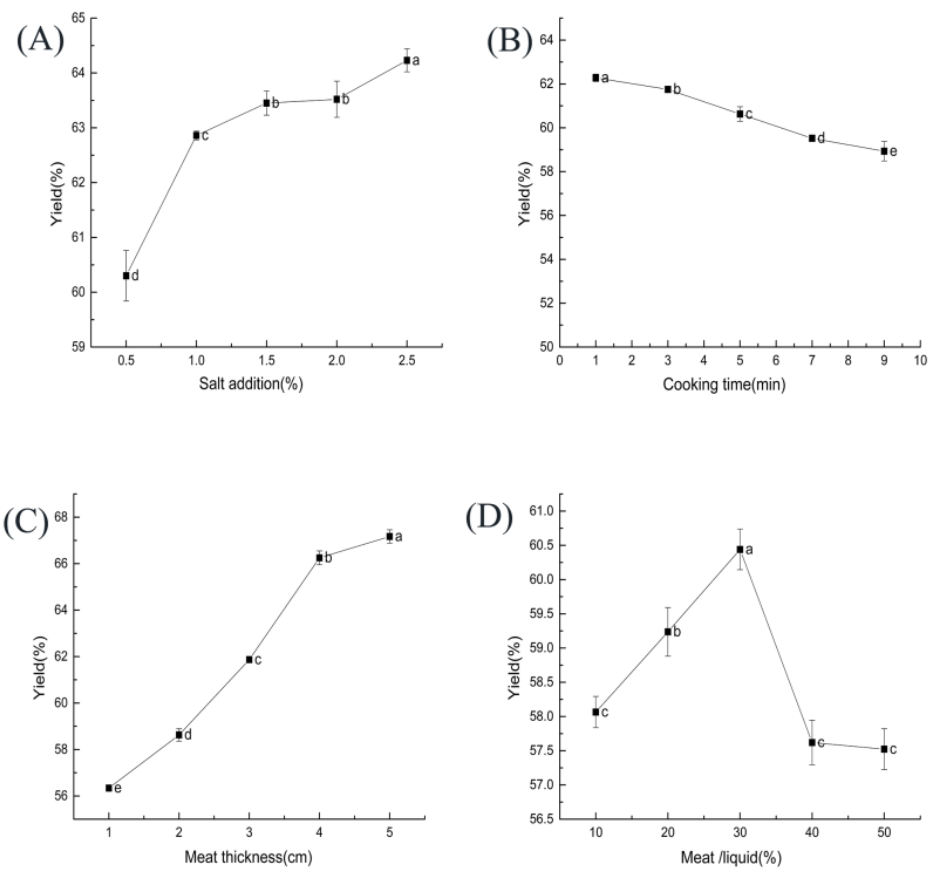
Figure 1. Effect of each factor on the yield of ST beef: ( A ) salt addition (based on ST mass); ( B ) cooking time; ( C ) meat thickness; ( D ) beef–ST ratio. Different letters above each bar mean significant differences.